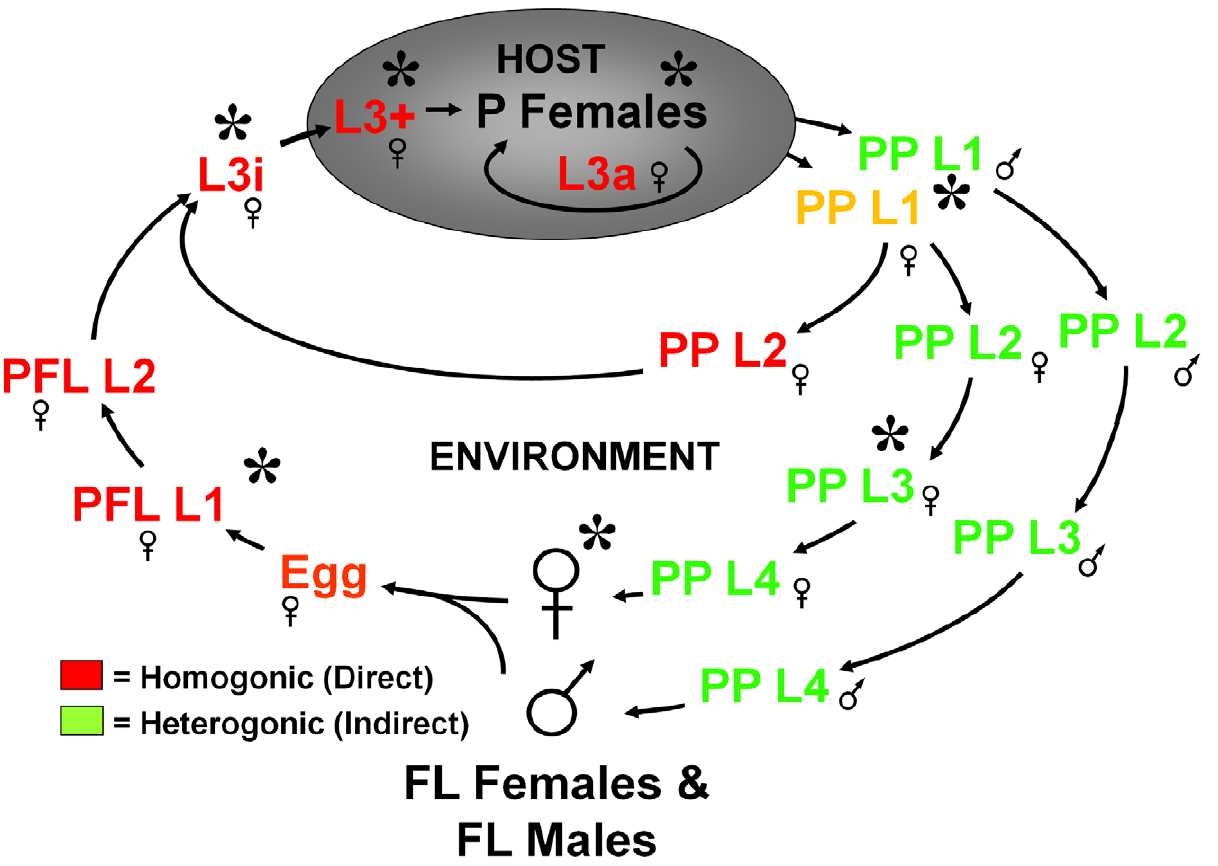
Figure 1. Diagram of the Strongyloidesstercoralis life cycle. Developmentally arrested infective third-stage larvae (L3i) can form by either a homogonic route (dark red) or a heterogonic route (light green). Female post-parasitic first-stage larvae (PP L1) passed in the feces of the infected host can develop homogonically through two larval molts directly to L3i or heterogonically through four larval molts to free-living females (FL Females). Post-parasitic L1 males invariably develop heterogonically through four molts to free-living males (FL Males). Post-free-living L1 (PFL L1), which are all female, molt twice and develop exclusively to L3i. Upon encountering and penetrating a susceptible host, activated third-stage larvae (L3 + ) resume feeding and development, migrate to the intestines, and molt twice into parasitic females (P Females). Post-parasitic L1 larvae can also precociously develop into auto-infective third-stage larvae (L3a) entirely within the host. Developmental stages marked with an asterisk (*) were interrogated by RNAseq. Adapted from